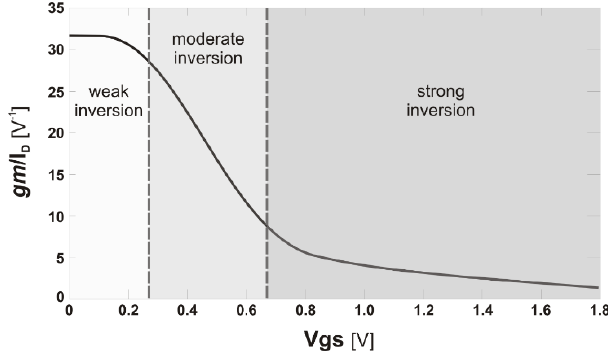
Figure 2. gm/I D versus V gs . Figure 2. gm / I D versus V gs